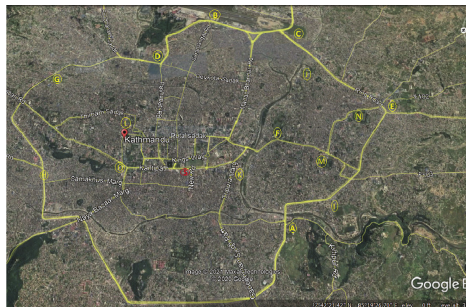
Figure 1: Road network for case illustration taken from Google Earth Pro where S denotes source (New Road) and letters from A to O are sink (Balkhu) and other prioritized intermediate vertices as mentioned in Table 2. Outer boundary traced yellow is Ring